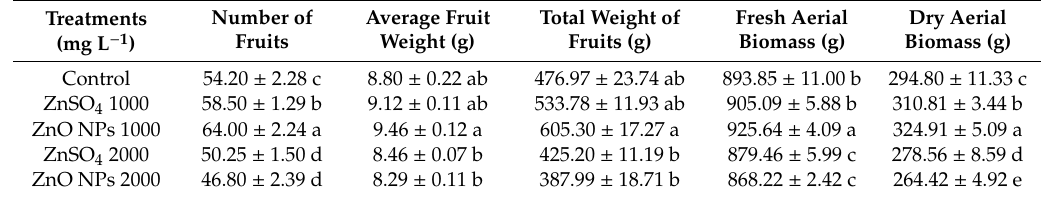
Table 1. E ff ect of foliar application of ZnO NPs and ZnSO 4 on fruit development and biomass